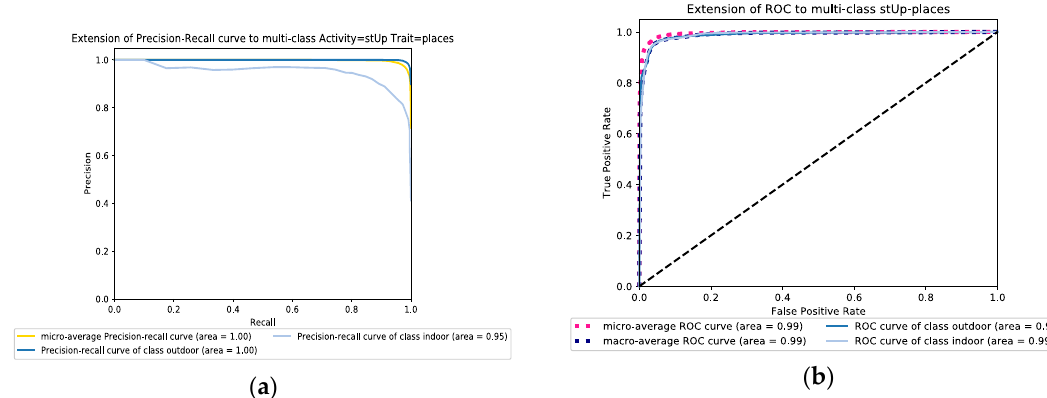
Figure 9. ( a ) The precision-recall graph and ( b ) the ROC graph of the RF model for the climbing stairs